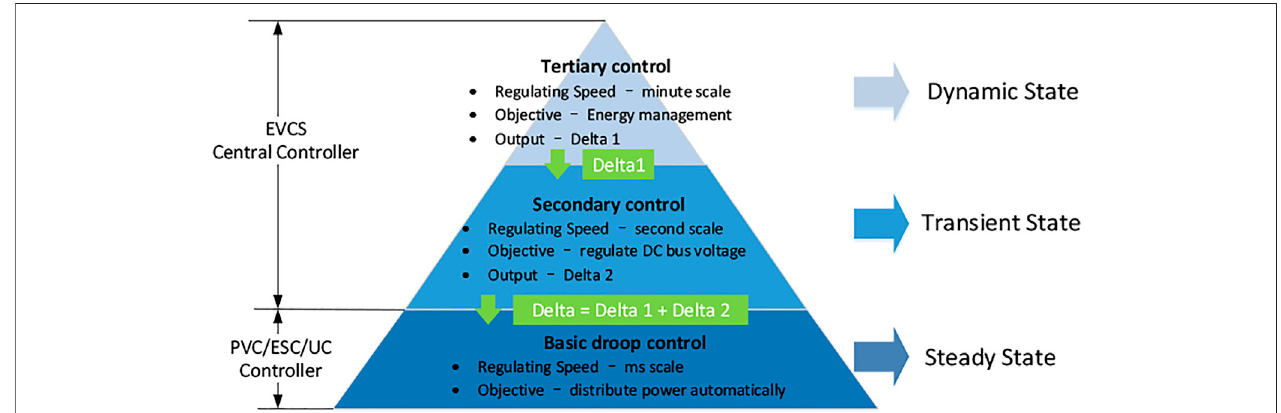
FIGURE 1 | Overview of three-level coordinated control system for the integrated charging